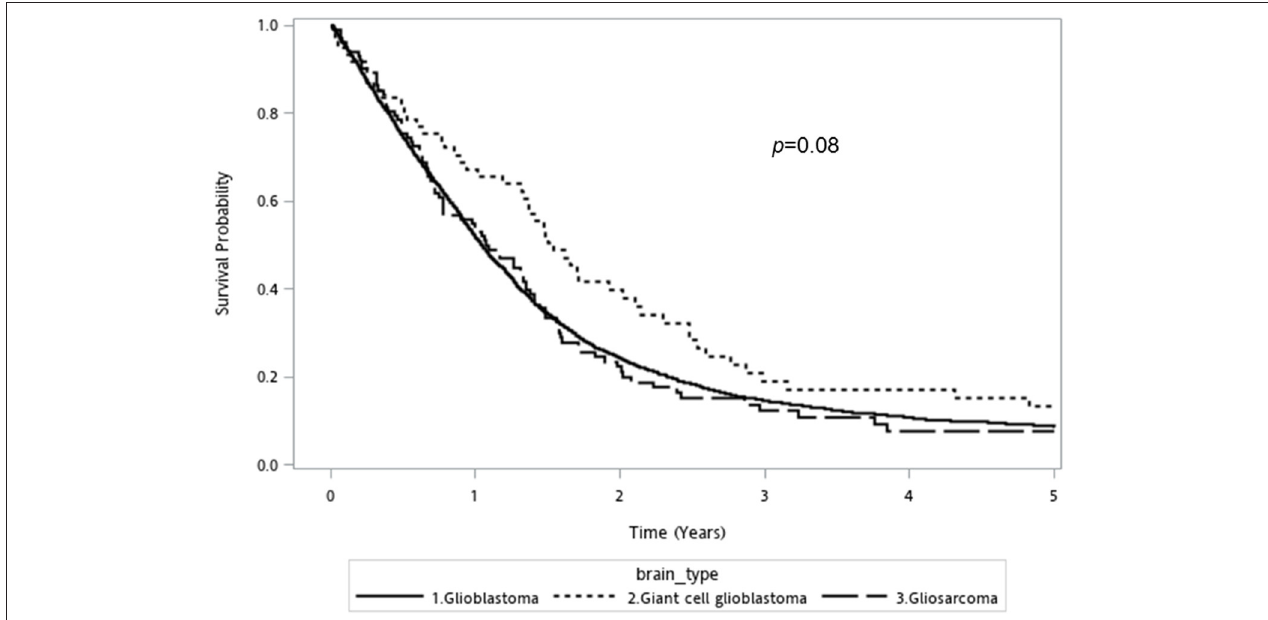
FIGURE 1 | Kaplan-Meier overall survival curve for conventional glioblastoma, giant cell glioblastoma, and gliosarcoma (log rank p- value = 0.08).